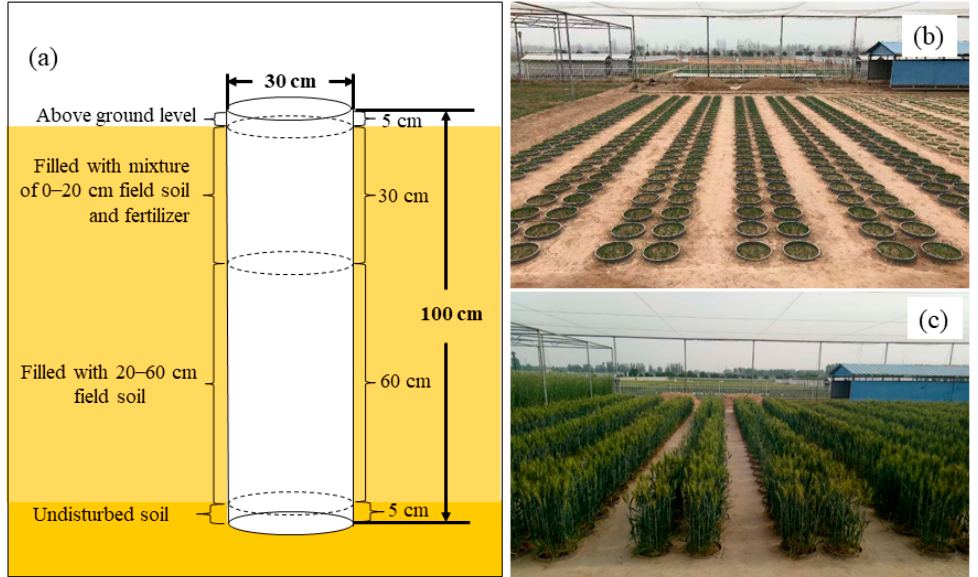
Figure 2. Schematic diagrams of soil columns used for winter wheat cultivation and the experi-mental plot ( a ). A diagram showing how columns were filled with soil ( b ). Image showing wheat cultivation at pustulation period ( c ) .